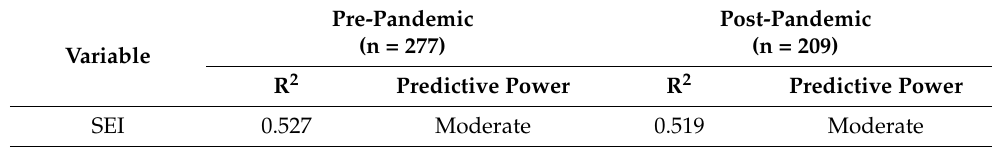
Table 11. Coefficients of determination (R 2 ).